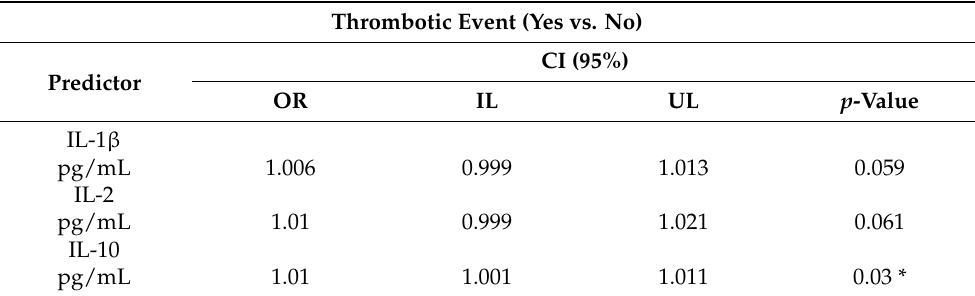
Table 8. Association effect of interleukins 1 β , 2, and 10 on thrombotic events for hospitalized patients with clinical symptoms of COVID-19 in a hospital in the Tri â ngulo Mineiro region, Brazil. Thrombotic Event (Yes vs.